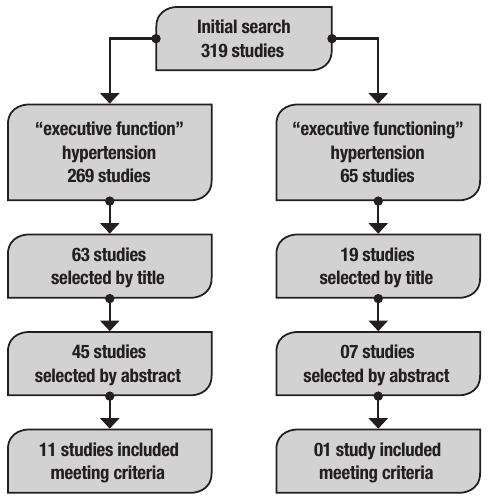
Figure 1. Literature search flow diagram.